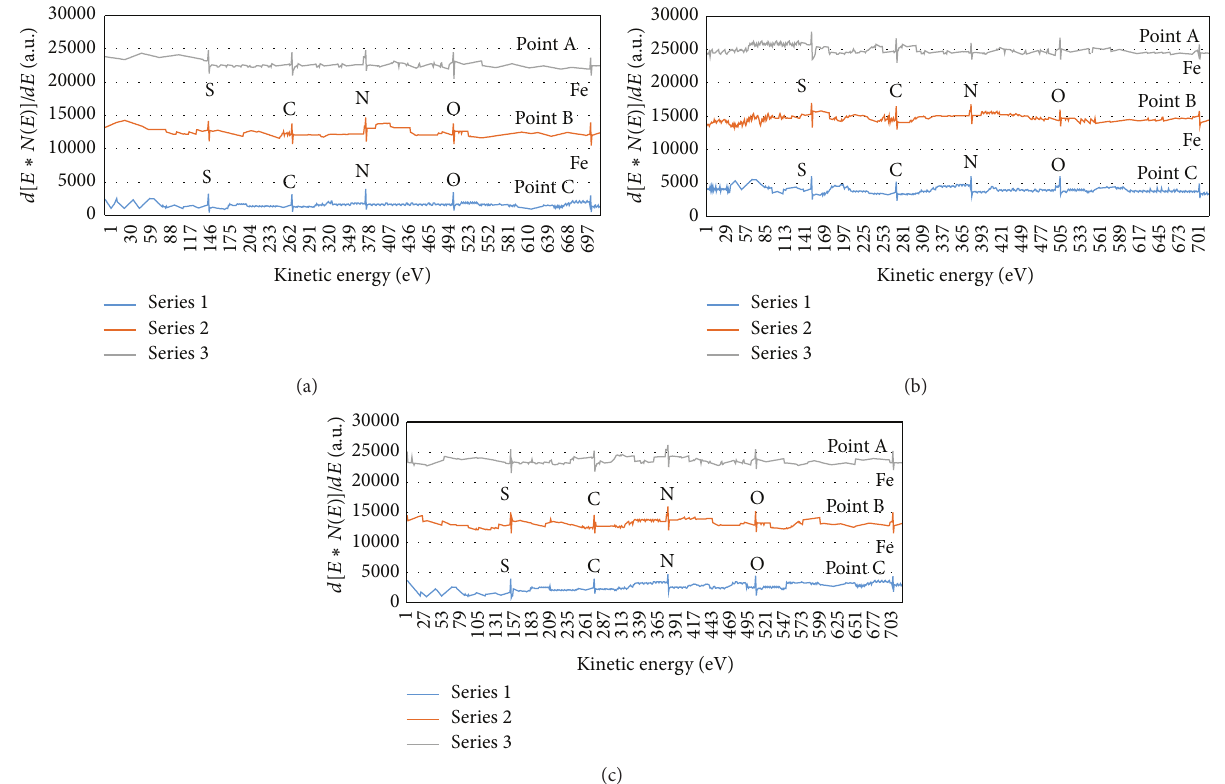
Figure 4: AES analyses of steps of development of a spore as MO in a SC in Tijuana at (a) one day, (b) three days, and (c) six days